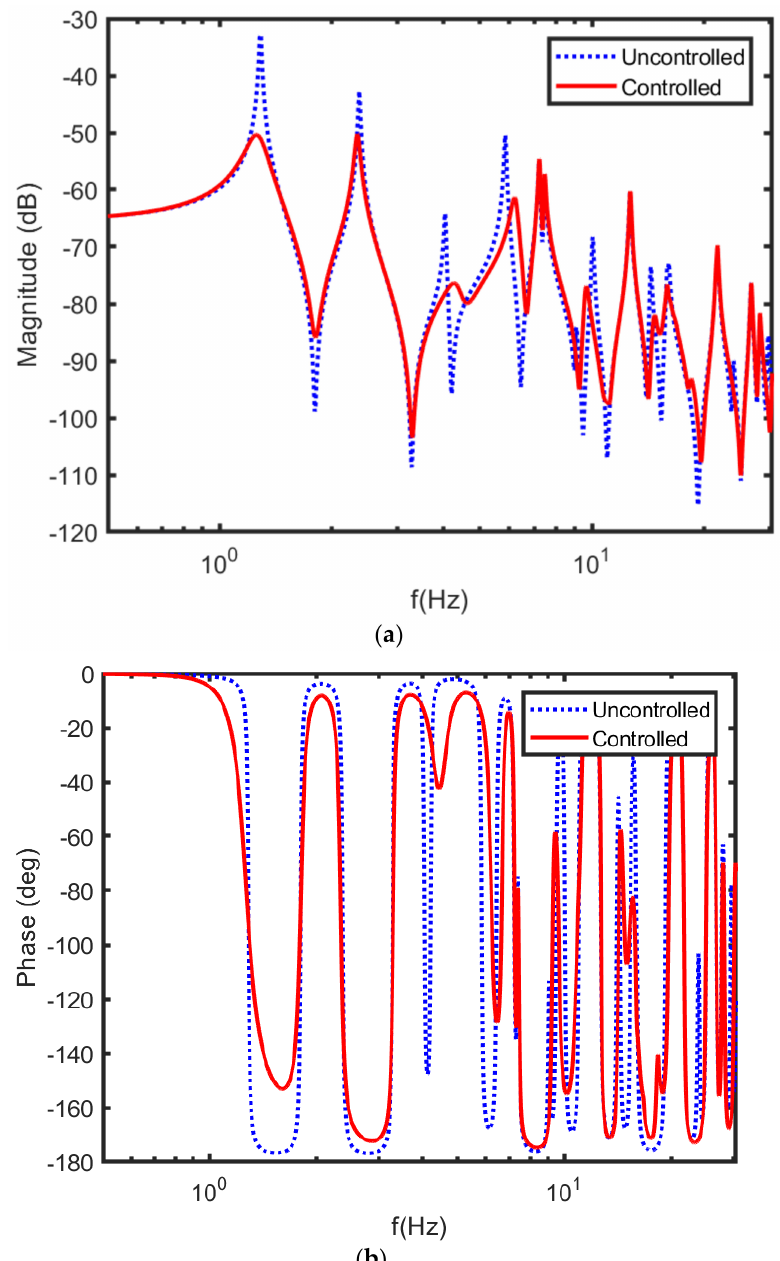
Figure 6. Frequency response function of the partially submerged plate (H = 0.3 m) controlled by decentralized MIMO modal-space NAF, ( a ) magnitude and ( b ) phase.